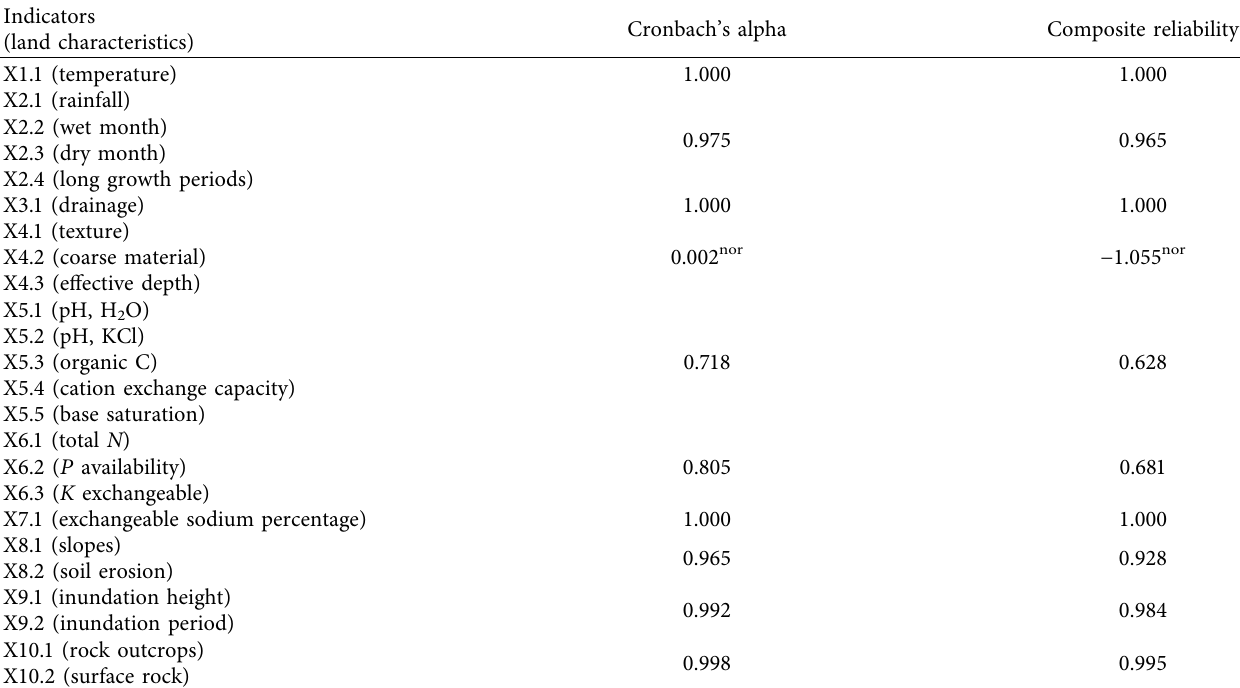
Table 6: Composite reliability and Cronbach’s alpha